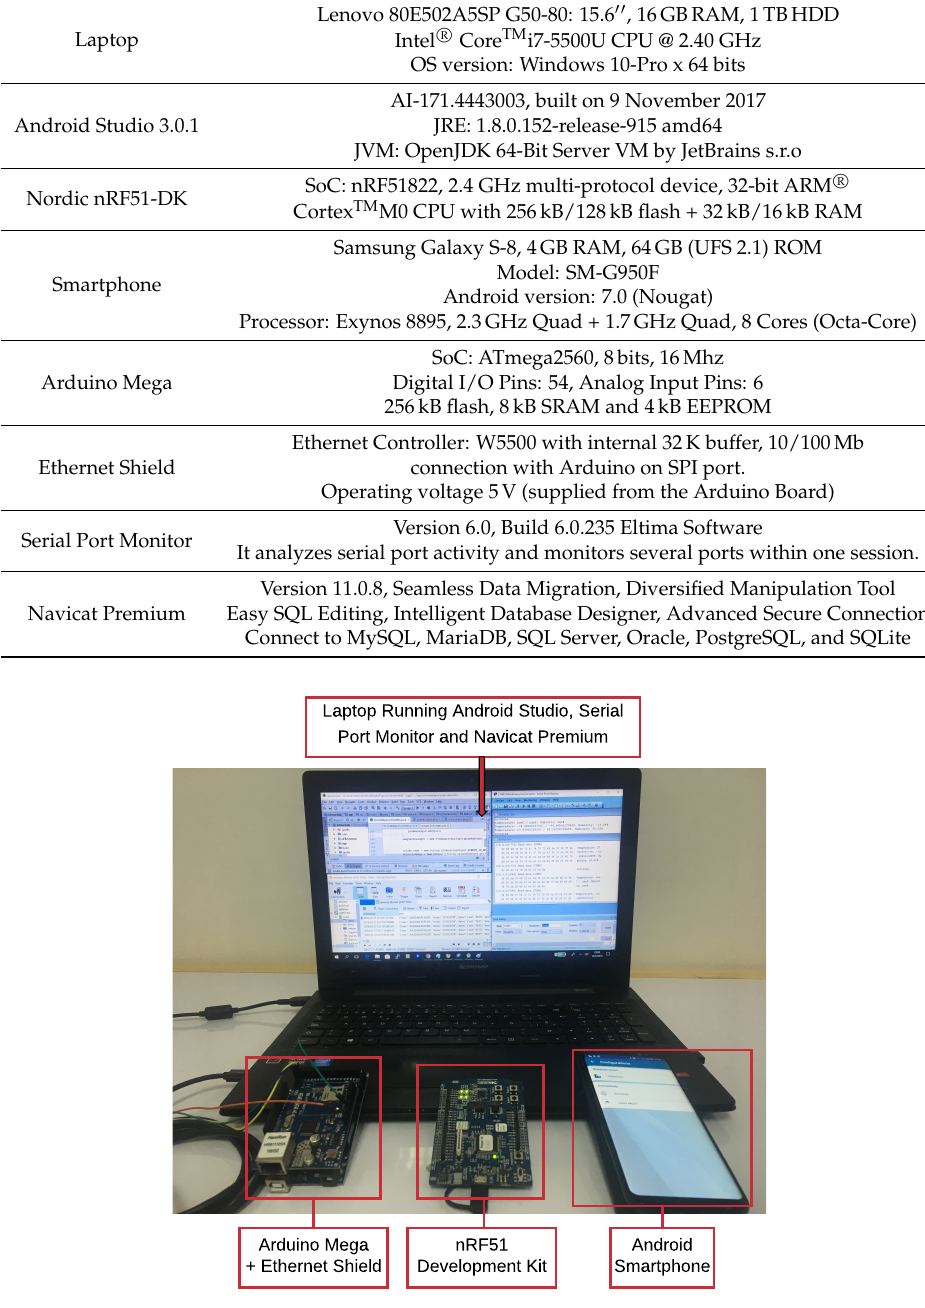
Figure 27. Experimental